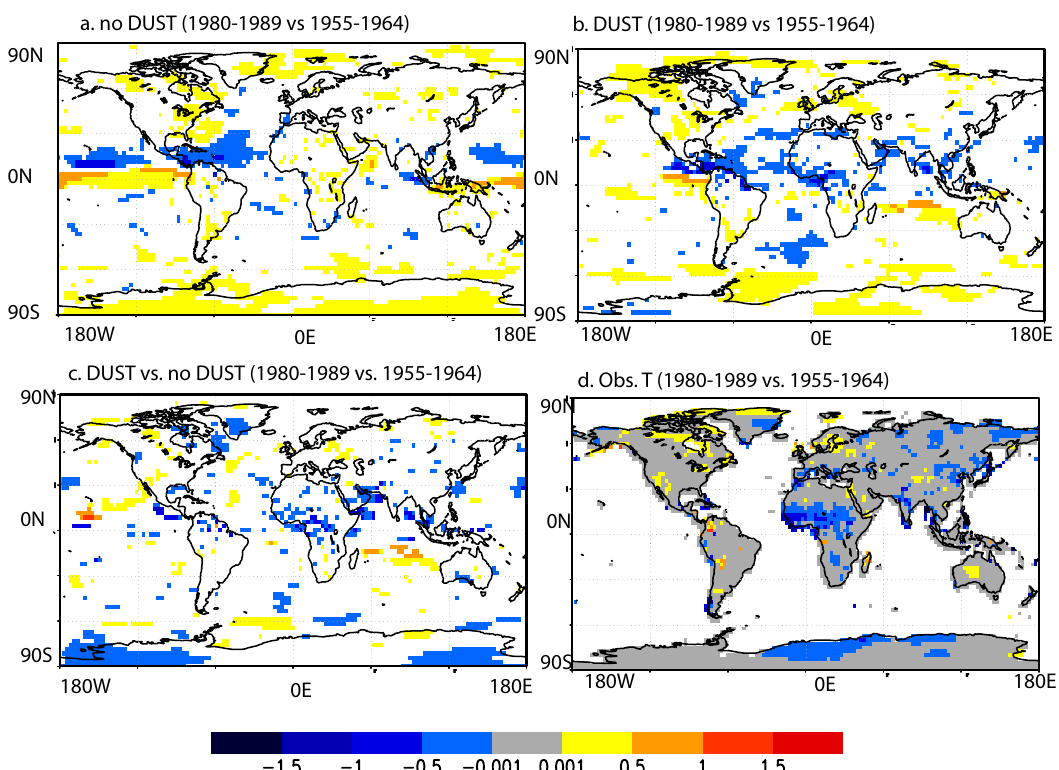
Fig. 6. Model estimated change in precipitation for 1980–1989 vs. 1955–1965 with no dust radiative forcing (a) , with dust radiative forcing (b) , and the difference in the precipitation change (1980–1989 minus 1955–1965) between simulations with and without dust radiative forcing (c) . The change in precipitation between 1980–1989 vs. 1955–1965 from observations (only over land) (d) . For (a–c) only statistically significant results at the 95% confidence level are shown, including all the ensemble members. For (d) the grey color indicates where observations are available, but did not show a statistically significant result (grey is below the statistically significant level for the modeled